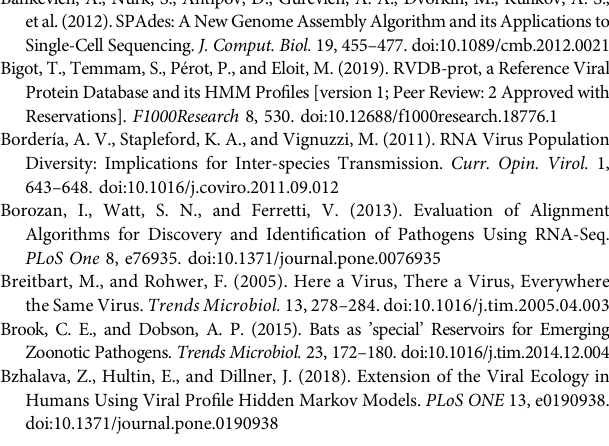
Figure S10 | Rate of families recovered per metagenome sample according to the length of reads. Table S1 | Proportion of sequences of viral origin detected in each SRA with their respective associated metadata information. Table S2 | Rate of viral protein signals according to family and type of metagenome analyzed.Also, the table describes functional information of the related proteins. Table S3 | Table of viral signals related to metadata and description of the related protein. TableS4| Resultsofcontigsprocessedbyblastn.Itshowsthesequenceswiththeir metadata and taxonomical information. Table S5 | Metadata used to classify families by genome type and host. Table S6 | Table of results of random sampling analysis of reads against Blastp using a non-viral database. it shows the sequences with a high percentage of identity ( > 70%). Table S7 | Table of results of random sampling analysis of contigs against Blastp using a non-viral database. it shows the sequences with a high percentage of identity ( > 70%). Table S8 | Tables of Distribution of the frequencies obtained by taxonomic assignment (Family) in each sample by pairwise alignment (Bowtie, Blast) and Hidden Markov comparison methods